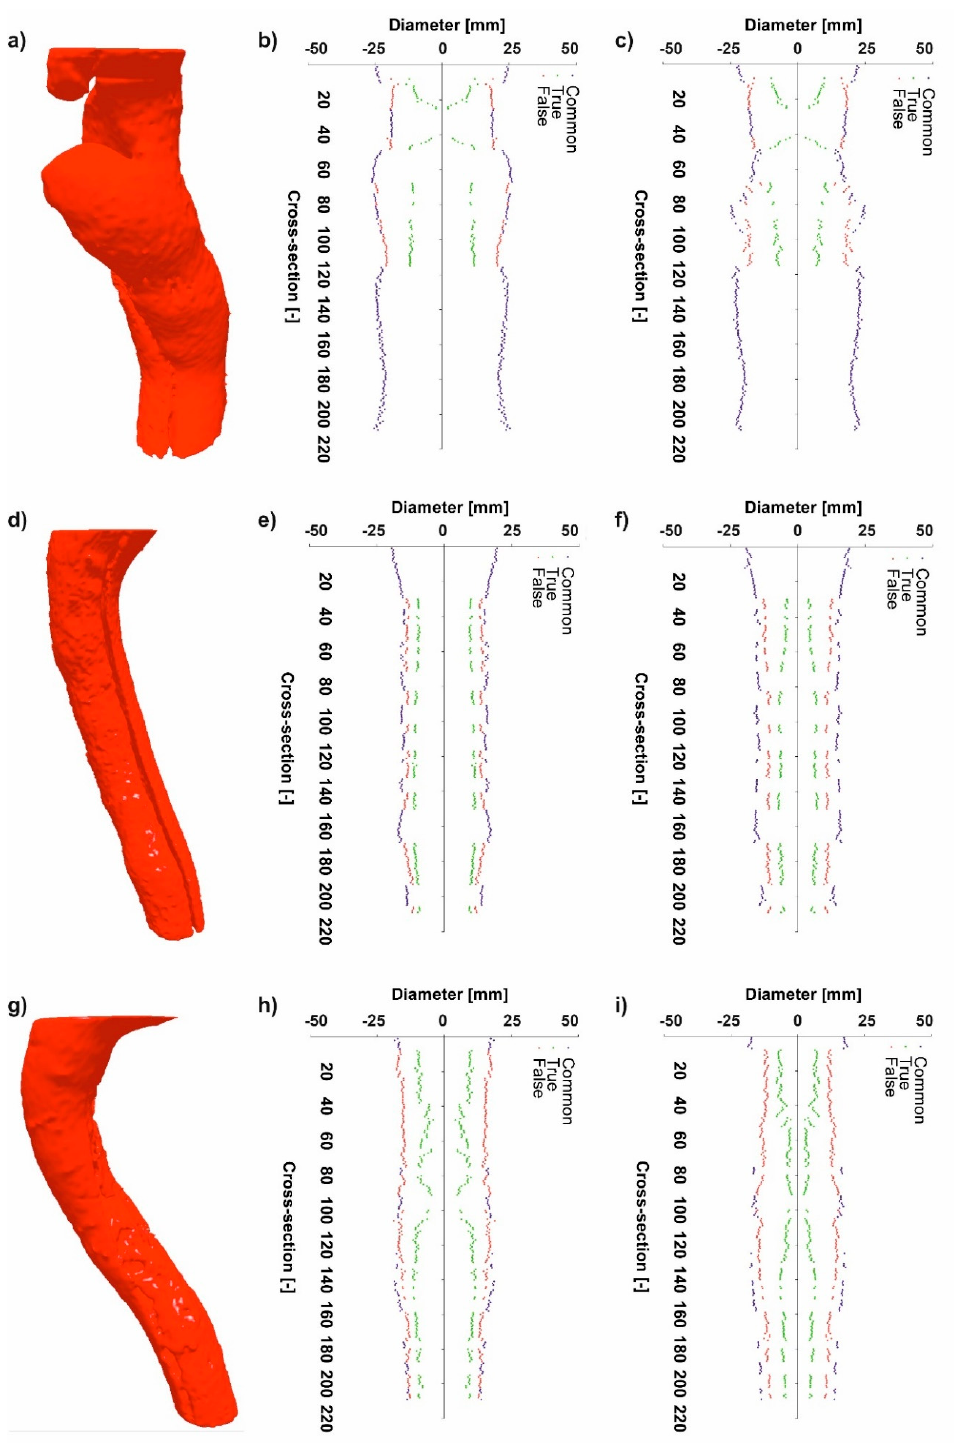
Figure 1. Spatial configuration of: ( a ) Patient 1 (P1), ( b ) D F calculated for common, false and true duct for P1, ( c ) D Hy calculated for common, false and true duct for P1, ( d ) patient 2 (P2), ( e ) D F calculated for common, false and true duct for P2, ( f ) D Hy calculated for common, false and true duct for P2, ( g ) patient 1 (P3), ( h ) D F calculated for common, false and true duct for P3, and ( i ) D Hy calculated for common, false and true duct for P3.